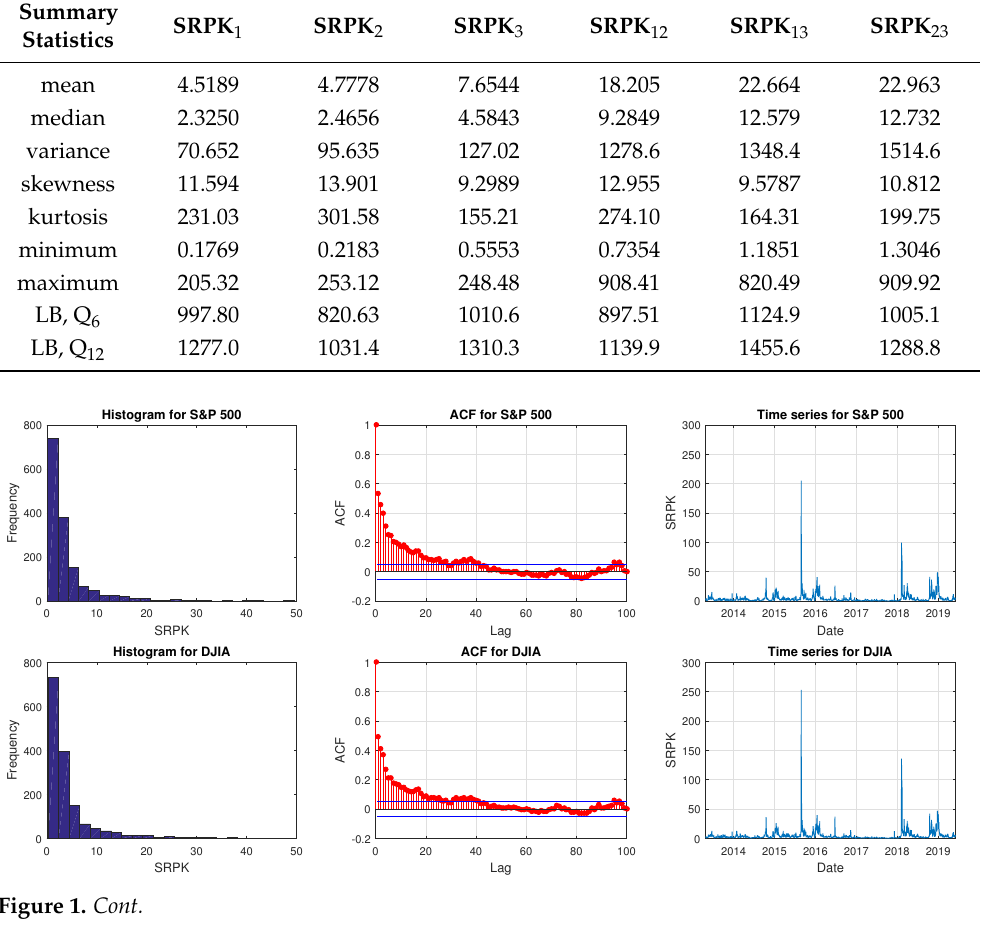
Table 1. Summary statistics of SRPK measures from 1 May 2013 to 31 May 2019 for S&P 500, DJIA, DJUSFI and their pairwise combined indices.